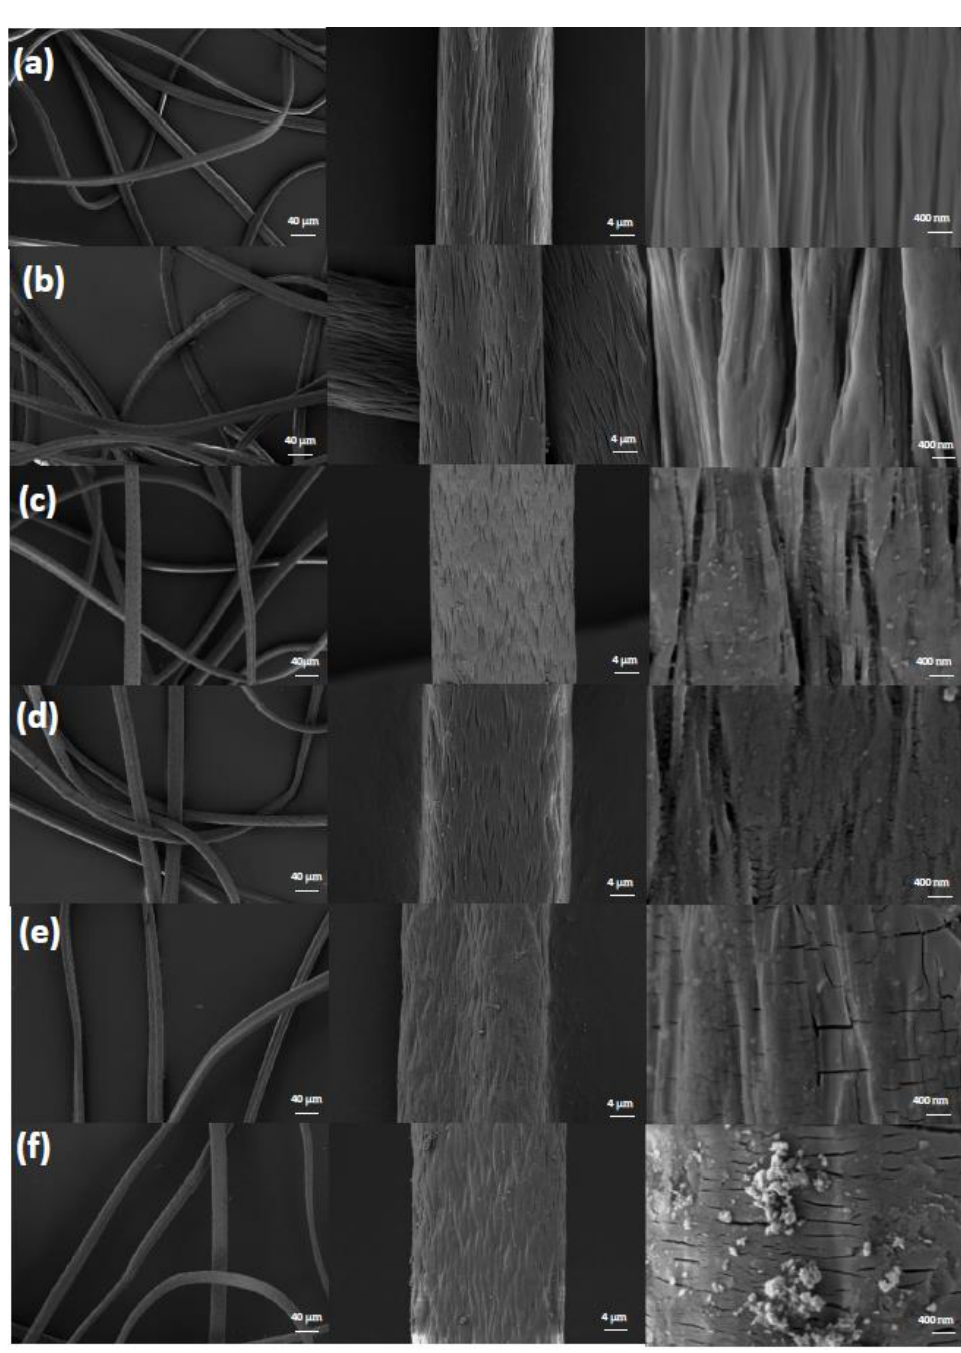
Figure 2. The SEM photographs of ( a ) PANF, ( b ) PAN A F, and ( c – f ) PAN A F-FeOOH prepared with Fe(OH) 3 colloid at 0.05, 0.2, 0.3, and 0.5 mol L − 1 , respectively. Magnifications are 200, 2000, and 20,000